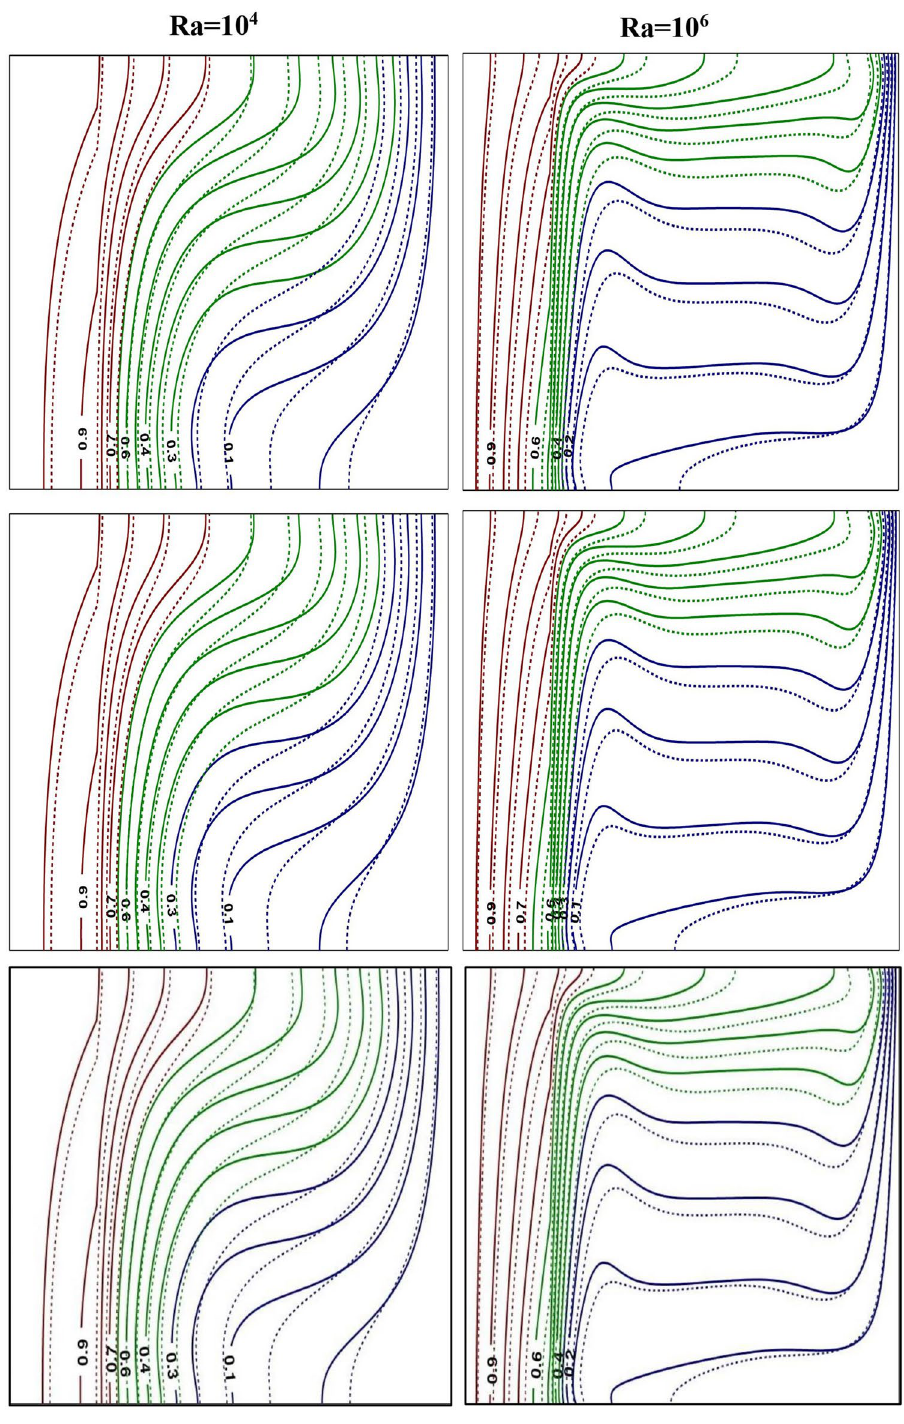
4 6 (left) and Ra = 10 (right) for base fluid (solid curve)